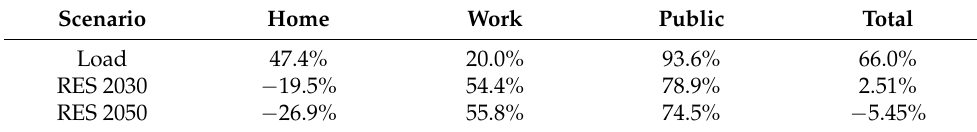
Table 2. Correlation between each charging profile and the RES and load profiles.